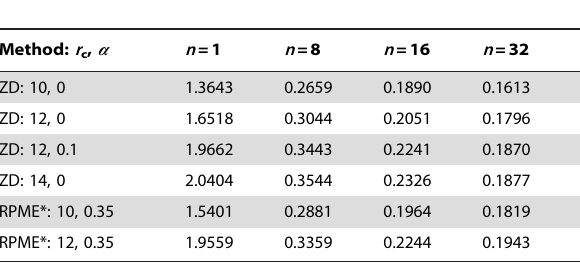
Table 1. Execution time (sec) for 1 step MD simulation of the DNA system by the ZD method and by the real space part of the PME (RPME)